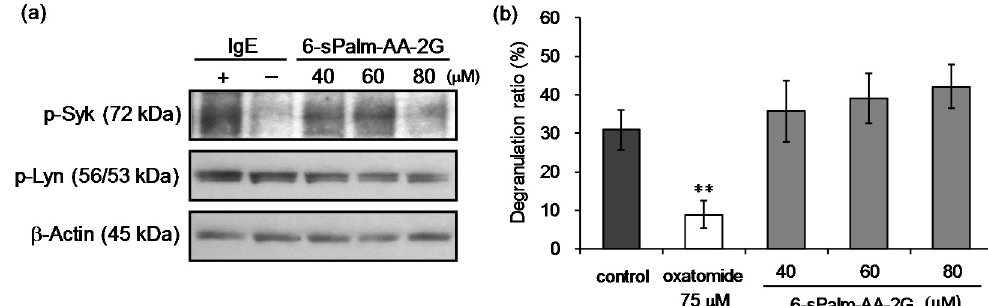
Figure 6. Effects of 6-sPalm-AA-2G on the signaling pathway leading to degranulation in RBL-2H3 cells. ( a ) Antigen-induced phosphorylation of Lyn and Syk kinases in RBL-2H3 cells; ( b ) Calcium ionophore A23187-induced degranulation. All data represent means ± SD of three independent cultures. ** p < 0.01 (Dunnett’s test) as compared with the control.